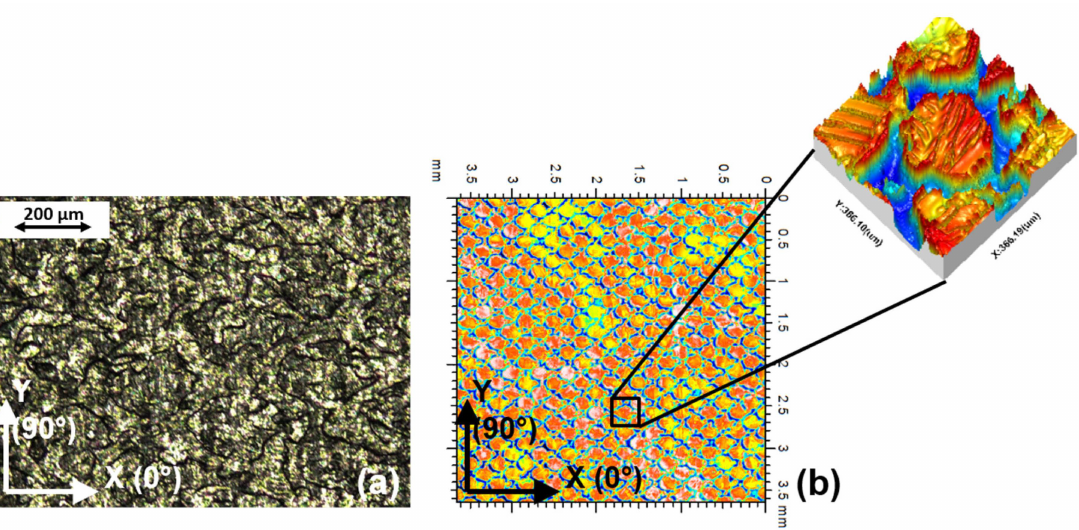
Figure 13. Optical visualization of the surface structure of DC06 steel: standard 2D microscopy ( a ) and 3D coherence correlation interferometry (after processing) ( b ).